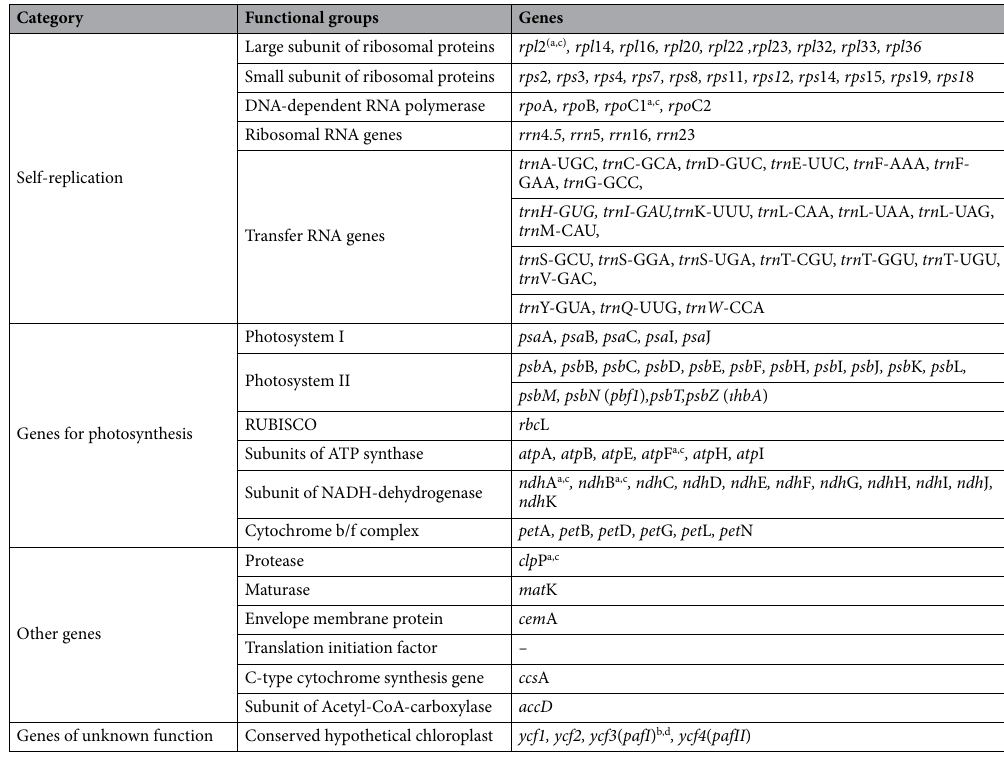
Table 2. List of chloroplast genomes gene content and functional classification in L. ervoides . a Gene containing one intron. b Gene containing two introns. c Gene with two exons. d Gene with three